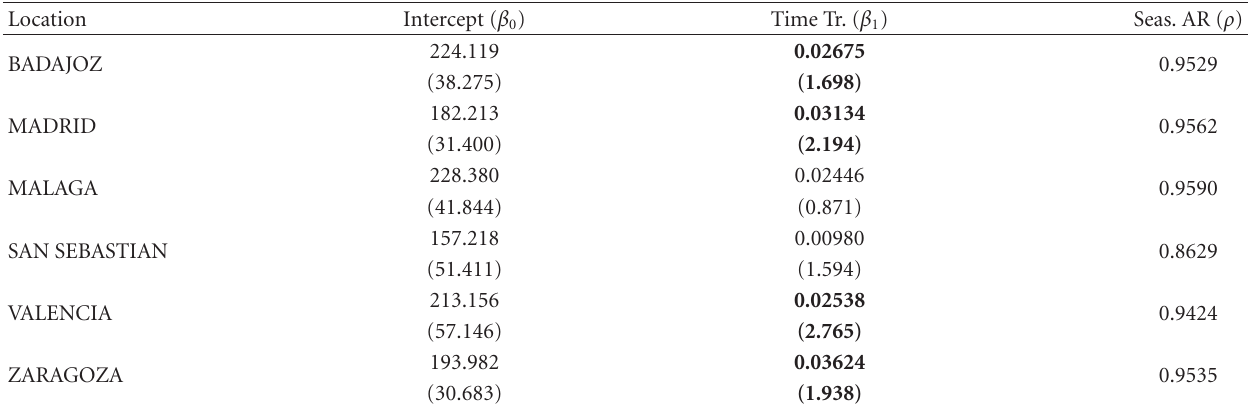
Table 3: Estimates of the time trend coe ffi cients and the seasonal AR(1) coe ffi cients assuming that the process is I (0), i.e., d = 0. Series: t -values in parenthesis. In bold, significant time trend coe ffi T max .